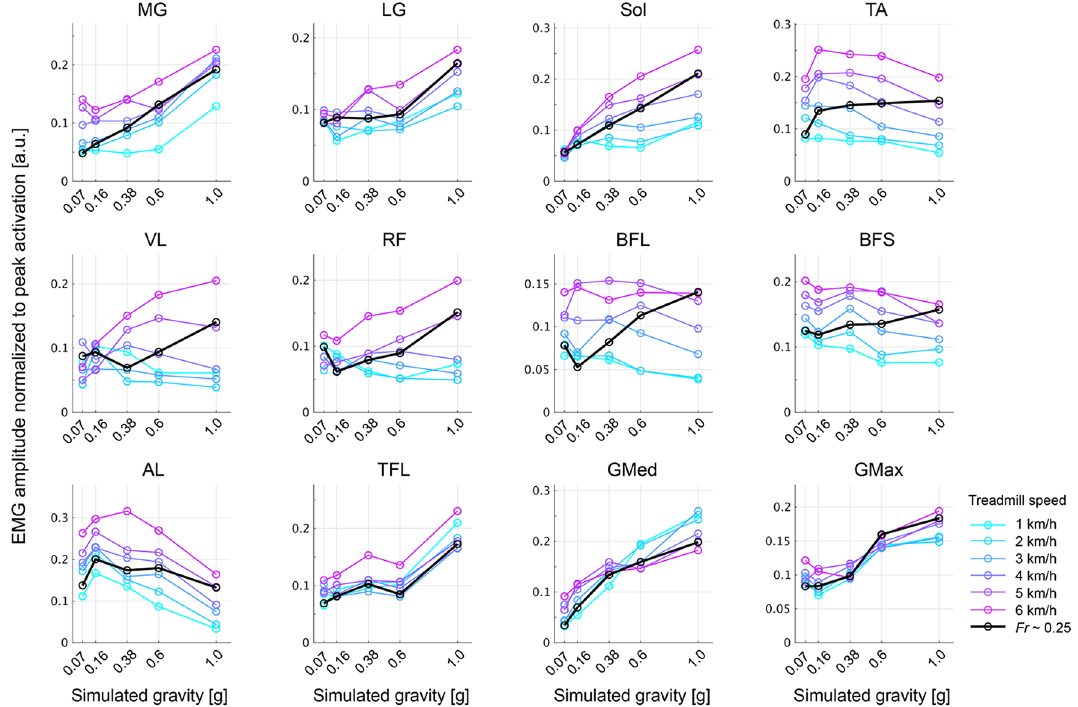
Figure 3. Mean muscle activity over time for all gravity levels and treadmill speeds. The processed EMGs shown in Fig. 2 are averaged across a series of gait cycles. The circles and lines for the individual treadmill speeds (1–6 km/h and speed corresponding to Fr ~ 0.25) are distinguished by